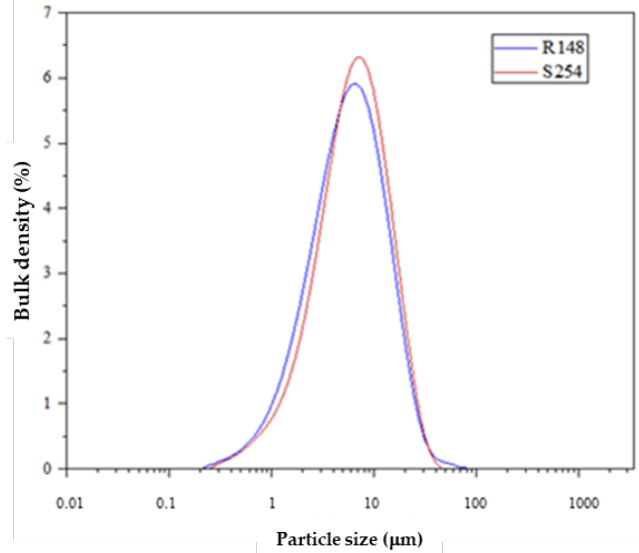
Figure 4. Particle size distribution for R148 and S254 additives.